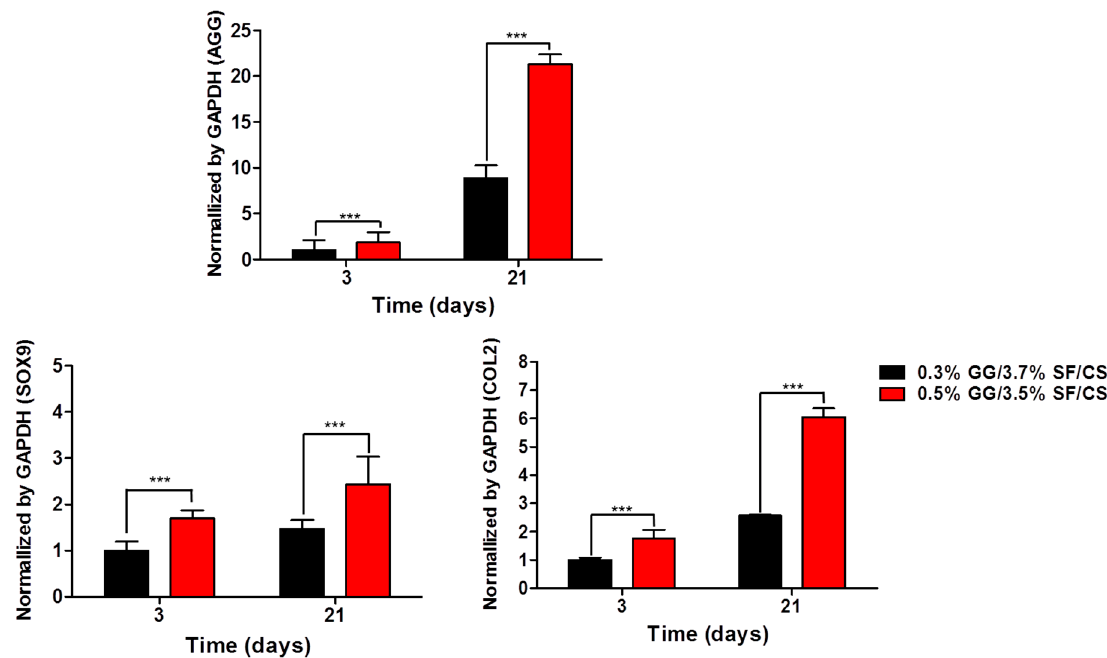
Figure 8. Cartilage-specific gene expression evaluated by RT-PCR with AGG, SOX9, and COL2 normalized by GAPDH (values are mean ± SD, n = 3, p < 0.001 (***)).